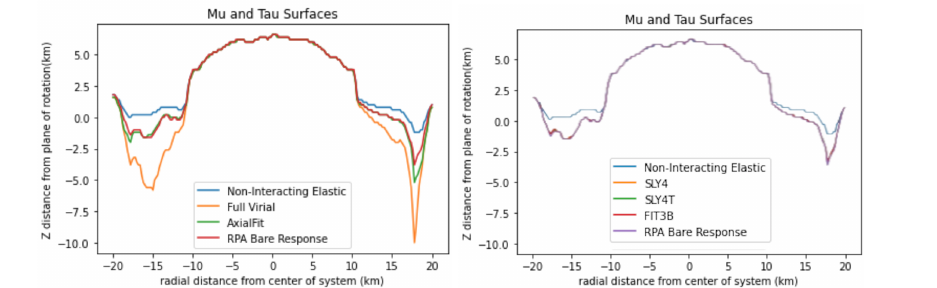
Figure 2: Muon(tau) neutrino surfaces using di ff erent neutral current cross sections. The left panel shows the di ff erences between the structure factors from the virial equation of state, a bare RPA response and a fit between the two, whereas, the right panel focuses on various parameterizations of the Skryme Energy Density